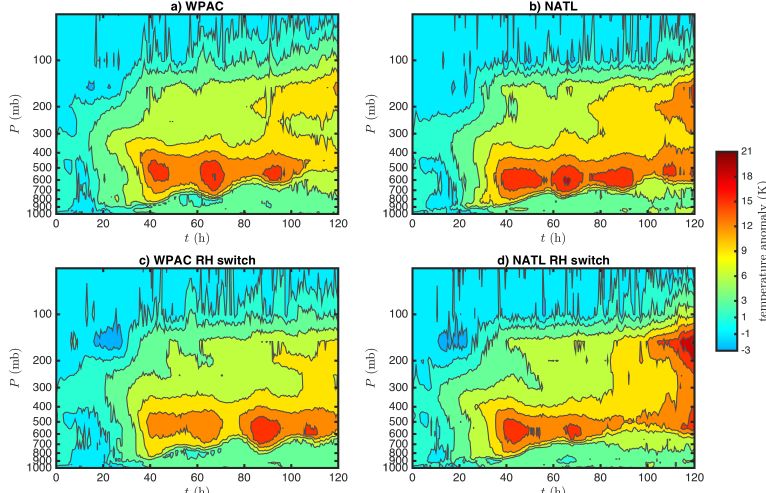
Figure 5. Hovmöller diagrams of the temperature anomaly at the center of the model vortex with respect to the far-field environment (shaded, unit K) for ( a ) WPAC-CTL; ( b ) NATL-CTL; ( c ) WPAC with the NATL moisture profile; and ( d ) NATL with the WPAC moisture profile. Contours are labeled on the color